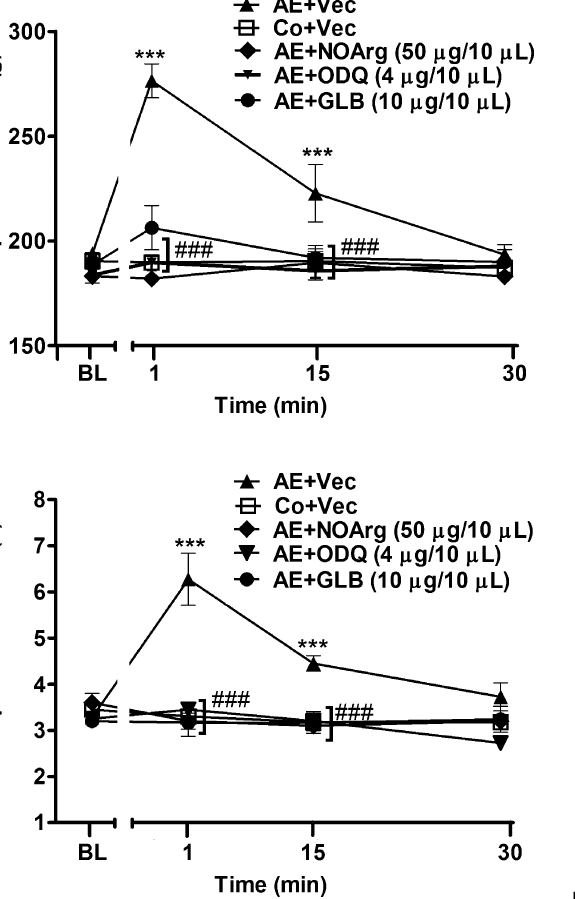
Figure 2. Effect of intrathecal administration of specific NOS inhibitors on the antinociception induced by acute aerobic exercise (AE) in the paw-withdrawal ( A ) and tail-flick ( B ) tests. Rats were pretreated with intrathecal injection of aminoguanidine (AMG, 10 m g/10 m L), N 5 -(1-iminoethyl)-L-ornithine dihydrochlor- ide (L-NIO, 10 m g/10 m L) and N v -propyl-L-arginine (L-NPA, 10 m g/10 m L) immediately before the onset of exercise, which lasted for a mean of 42.2±4.0 min. Mechanical and thermal nociceptive thresholds were measured before and after 1, 15, 30 min of AE. Data are reported as means±SE of 6 animals per group. ***P , 0.001, compared to the control group (Co); ### P , 0.001, compared to the AE group (one-way ANOVA followed by the Bonferroni test). Vec: vehicle; BL: baseline latency.